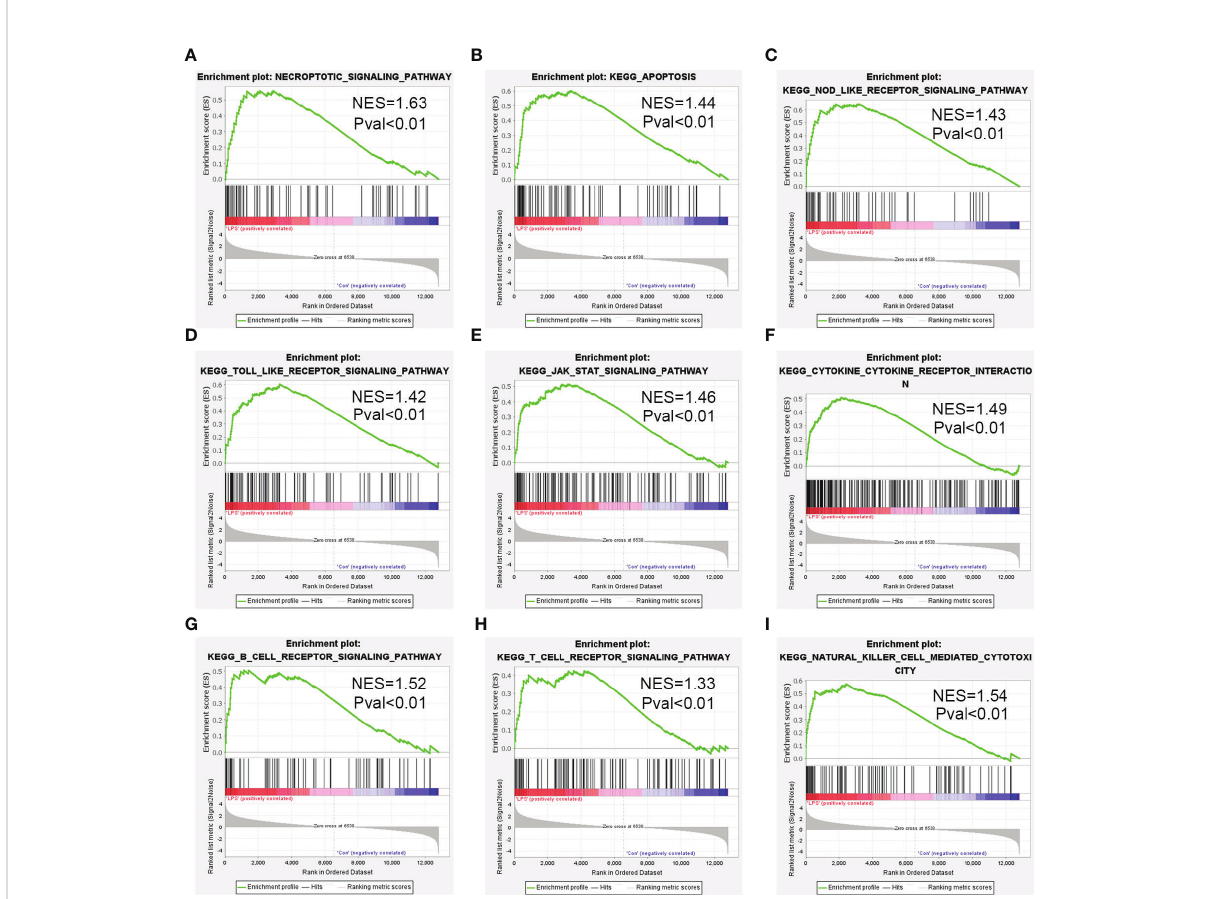
FIGURE 4 Enrichment plots from the gene set enrichment analysis (GSEA) for the highly enriched pathways in SIMD. (A) Necroptosis signaling pathway. (B) Apoptosis signaling pathway. (C) NOD-like receptor signaling pathway. (D) Toll-like receptor signaling pathway. (E) JAK-STAT signaling pathway. (F) Cytokine-Cytokine receptor interaction. (G) B-cell receptor signaling pathway. (H) T-cell receptor signaling pathway. (I) Natural killer cell mediated